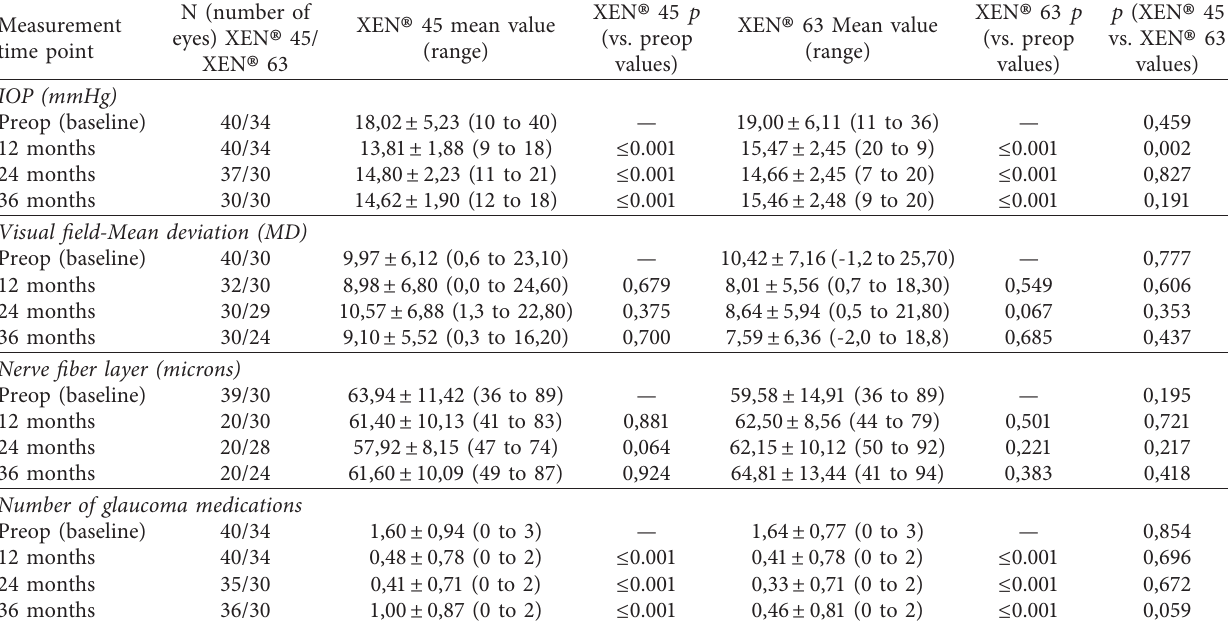
Table 2: Preoperative (baseline) and postoperative (for each follow-up visit) intraocular pressure (IOP), visual field mean deviation (MD), retinal nerve fiber layer (RNFL) thickness, and number of IOP-lowering medications required by the patient for XEN ® 45 and XEN ® 63 Gel Stent. Significance threshold was set at